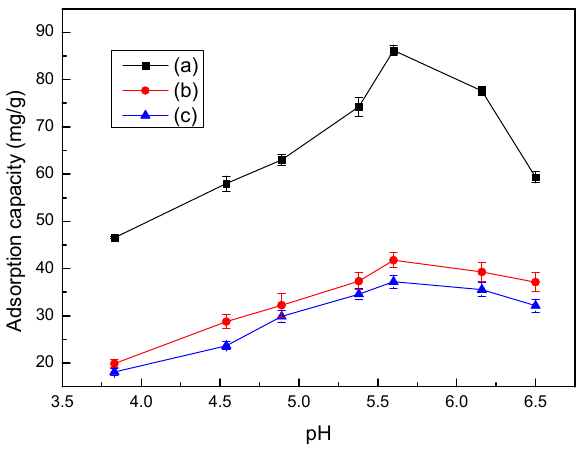
Figure 6. Effect of pH on adsorption capacity of LMT (a), MT (b), and LC (c). Adsorbent: 0.1000 g; initial Co(II) concentration: 0.0040 mol/L; temperature: 75 °C; and time: 60 min.